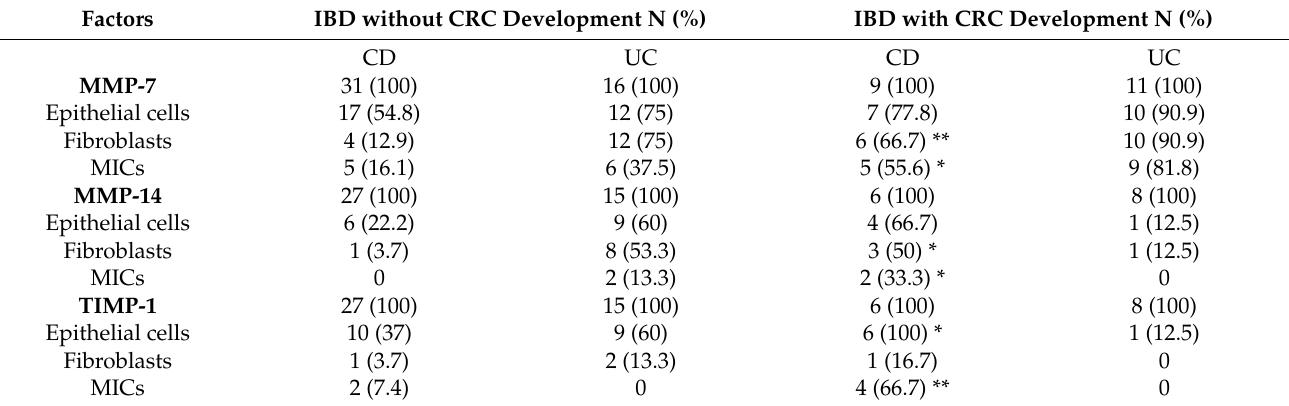
Table 5. Expression of MMP-7, MMP-14 and TIMP-1 by different cell types in non-inflamed tissue in IBD without or with CRC development. (% of cases refers to the total number of cases analyzed indicated for each